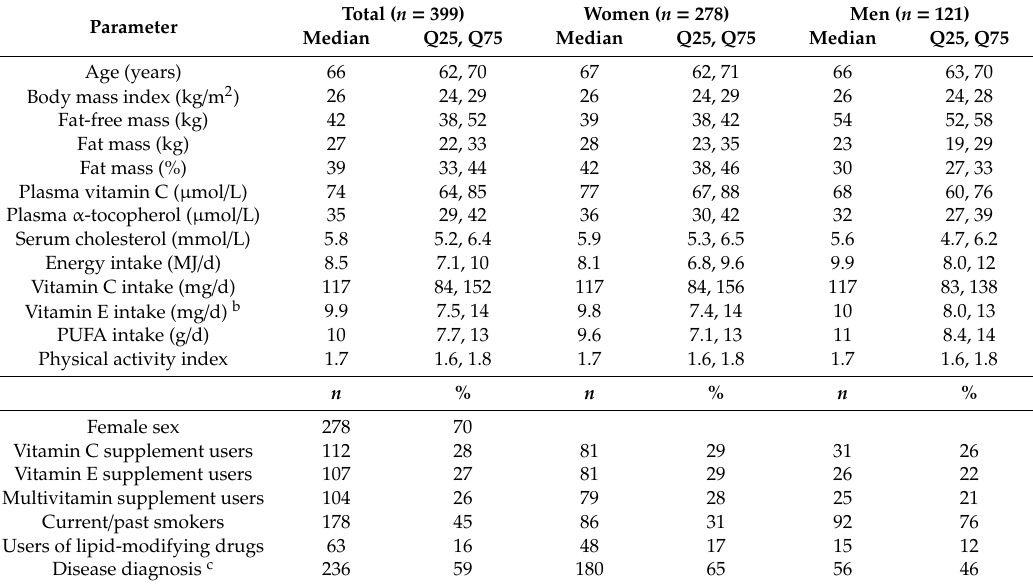
Table 1. Descriptive characteristics of the GISELA subjects at baseline a